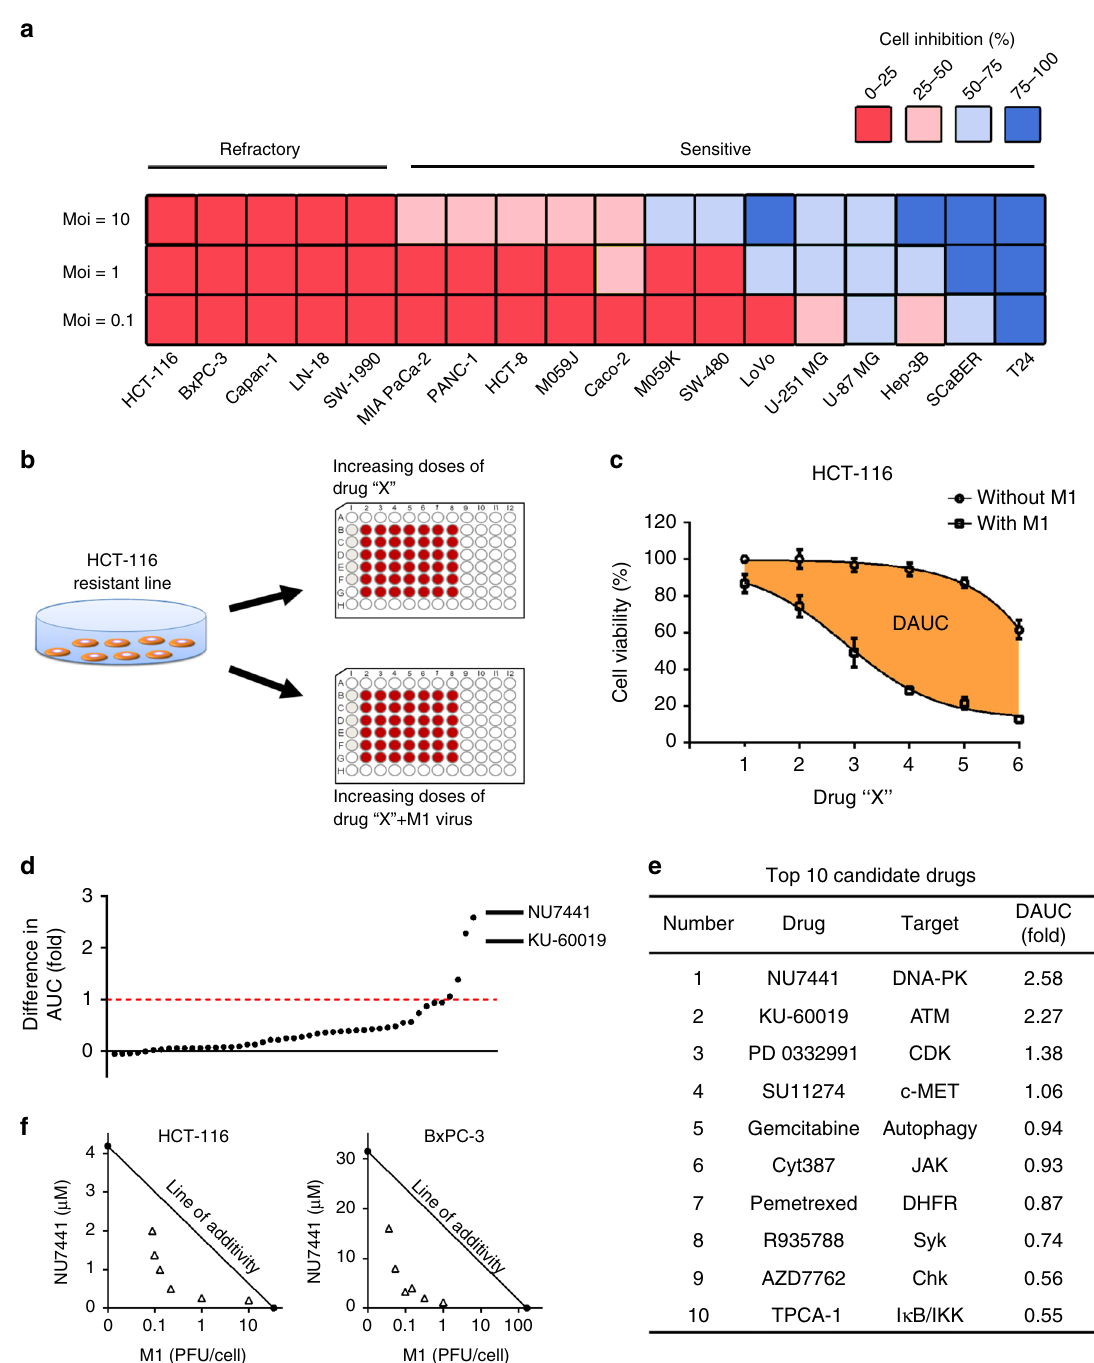
Fig. 1 Combinatorial drug screening identi fi es DNA-PKI NU7441 as the top sensitizer for OV M1. a Relative cell viability in 18 tumour cell lines treated with M1 (MOI = 10, 1 or 0.1). For each cell line, the percent cell inhibition is colour-coded by quartile. b A fl ow diagram of the drug-screening protocol. HCT-116 cells were treated with increasing doses of each compound in the absence or presence of M1 virus (MOI = 1) for 72 h. Then, cell viability was measured by the MTT assay. c Representative compounds for drug screening. Dose – response curves were generated for each drug in the absence or presence of M1 virus, and the DAUC (fold) was calculated according to the formula (AUC Single − AUC Combined )/AUC Combined ; the orange areas represent DAUC. d The agents were ranked according to DAUC (fold) between two dose – response curves for the HCT-116 cell line. Each dot represents one candidate drug from the anticancer compound library. e Top 10 candidate compounds identi fi ed through this screening. f IC50 isobolograms of the combined effects of NU7441/M1 in HCT-116 and BxPC-3 cell lines. The x and y axes represent equieffect doses for 50% cell killing by M1 and NU7441, respectively. The observed data points are indicated by the empty